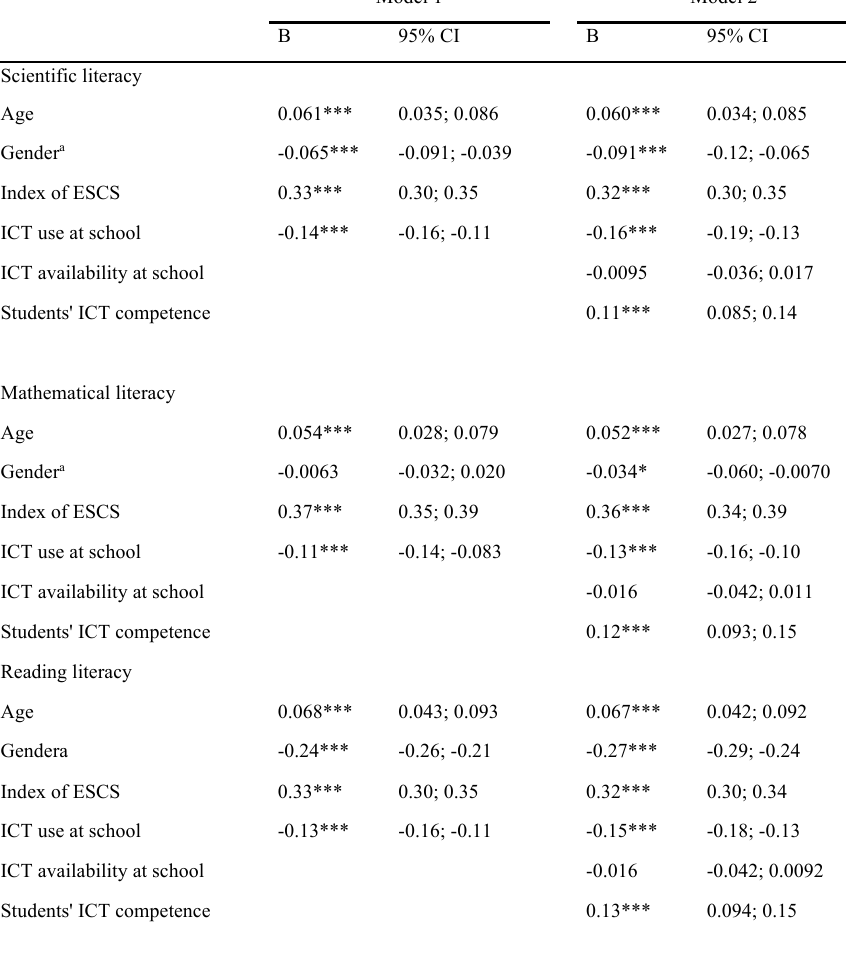
Table 2. The standardized coefficients (B) with 95% confidence intervals of the ICT variables, when predicting students’ performance in scientific literacy, mathematical literacy, reading literacy, and collaborative problem-solving with structural equation models